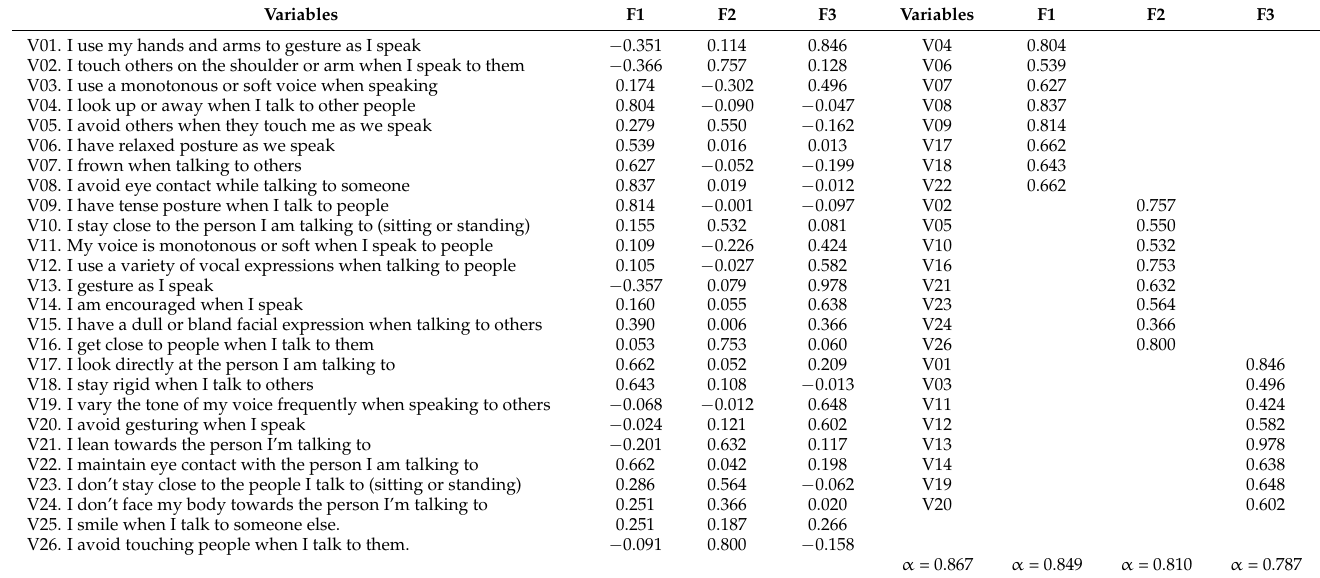
Table 2. Factor load of the dimensions of the Non-Verbal Immediacy